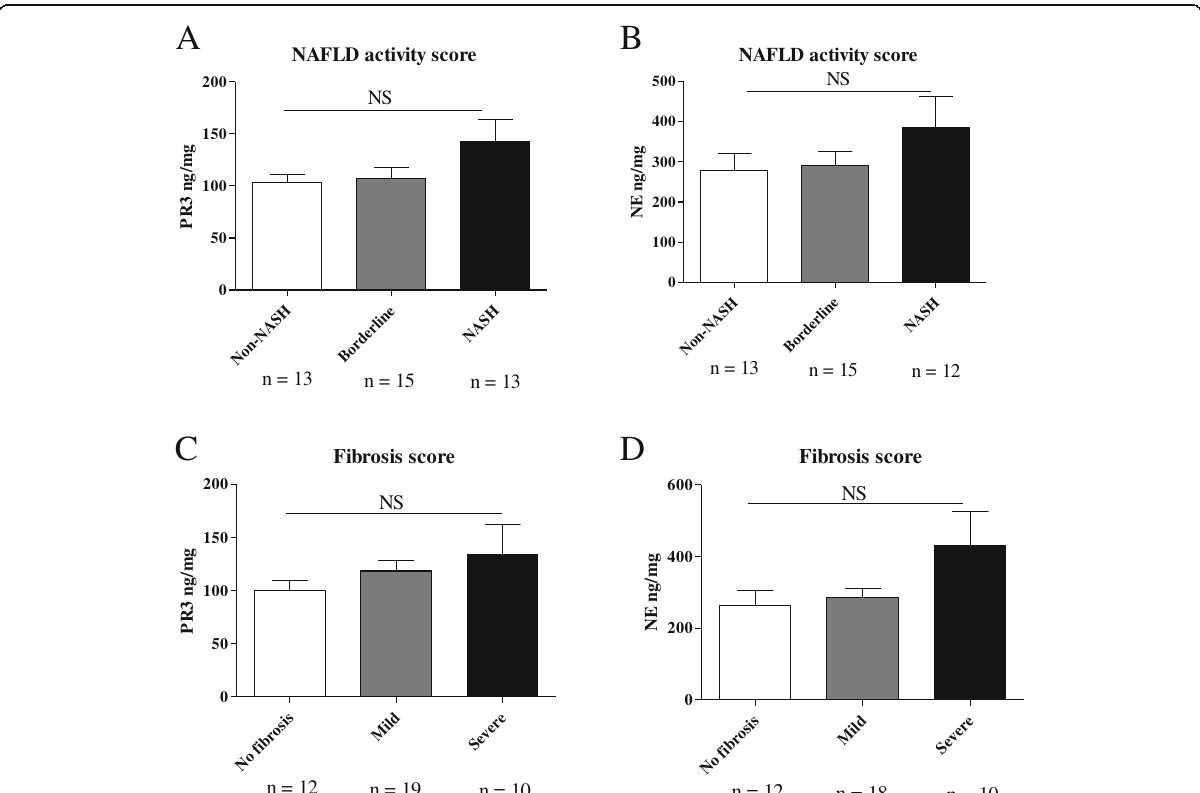
Fig. 2 PR3 and NE liver concentrations in patients biopsy-diagnosed with NAFLD . Assessment of NAFLD progression: patients with a NAFLD score (NAS) (Brunt et al. 2011) between 0 and 2 were considered without NASH, patients with a NAFLD score between 3 and 4 were considered borderline and patients with a score ≥ 5 were diagnosed with NASH. Assessment of fibrosis stage (Brunt scale): patients with a fibrosis score of 1 – 2 were considered as having mild fibrosis and patients with a fibrosis score of 3 – 4 were considered as having severe fibrosis. a PR3 concentrations in the liver of patients with different NAS. b NE concentrations in the liver of patients with different NAS. c PR3 concentrations in the liver of patients with different fibrosis scores. d NE concentrations in the liver of patients with different fibrosis scores. Data is represented as mean±SEM. NS= p